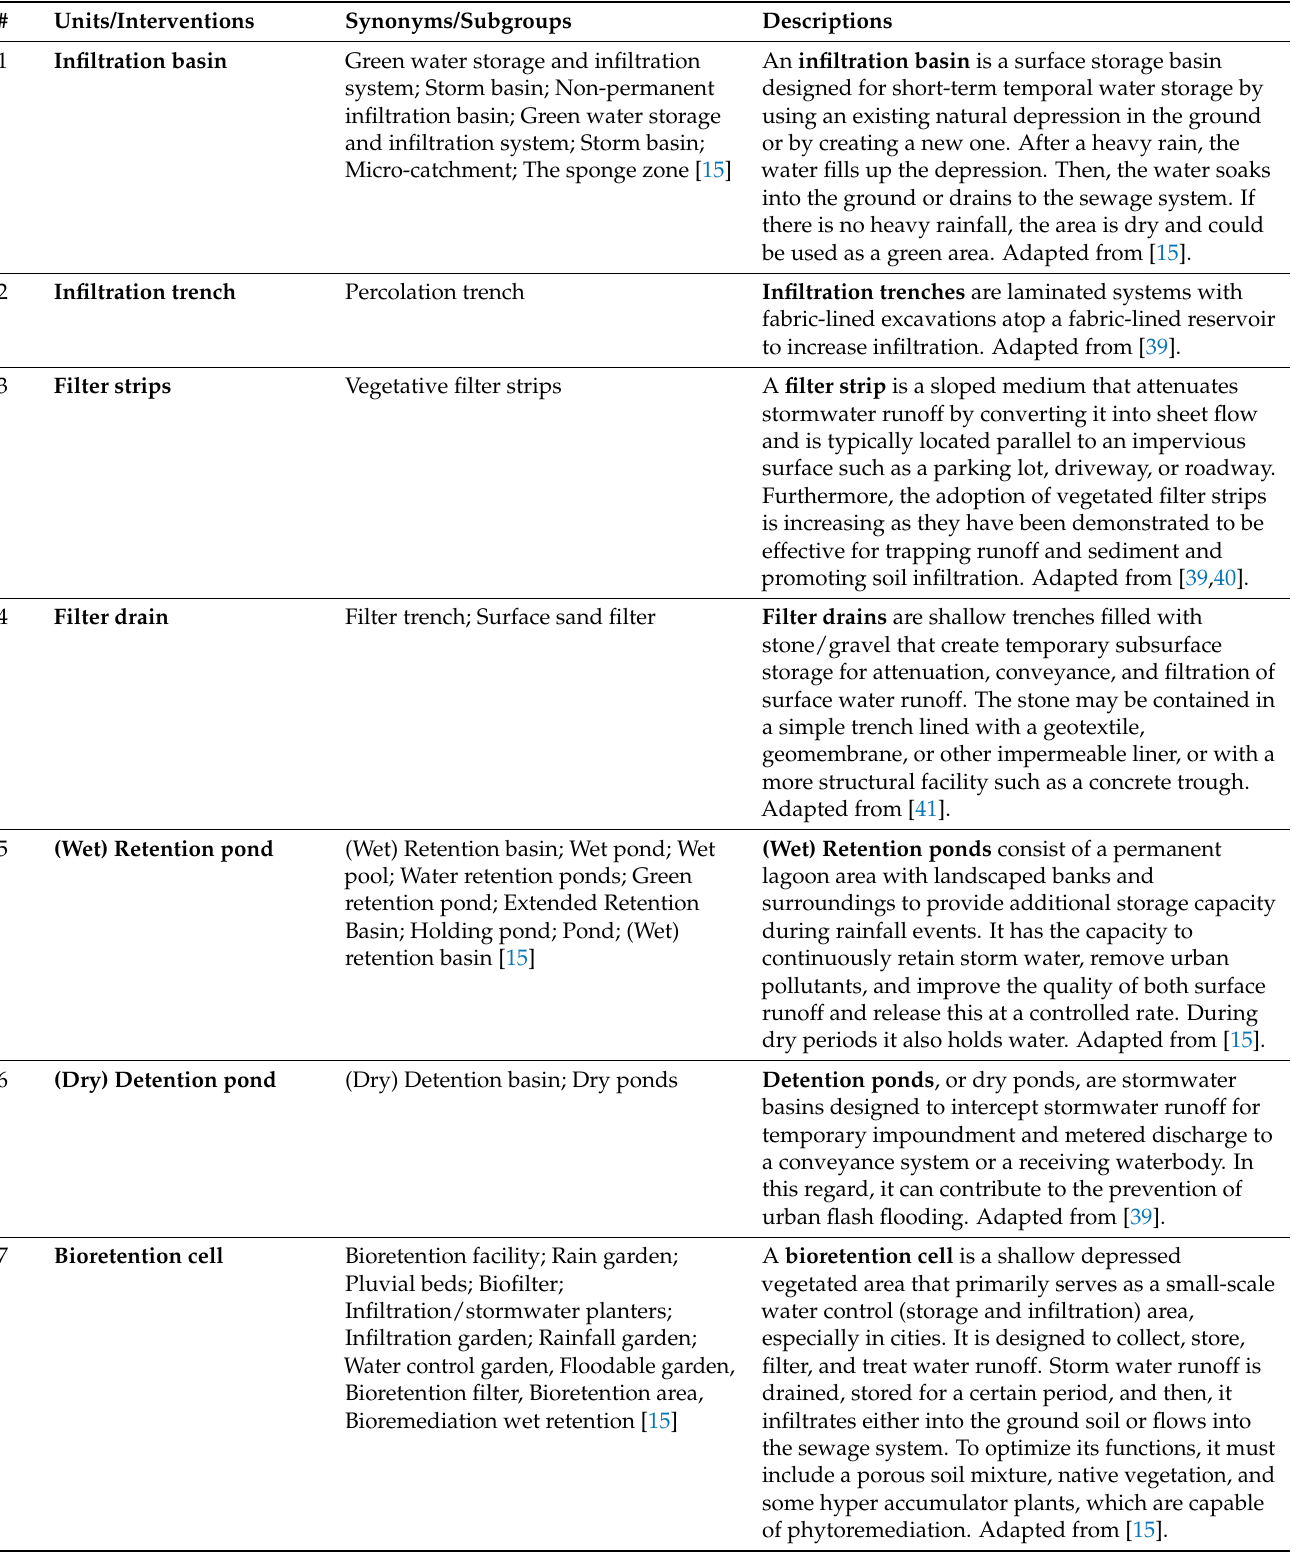
Table A2. Descriptions and synonyms/subgroups of NBS units (NBS_u), NBS interventions (NBS_i), and Supporting units (S_u) from Table